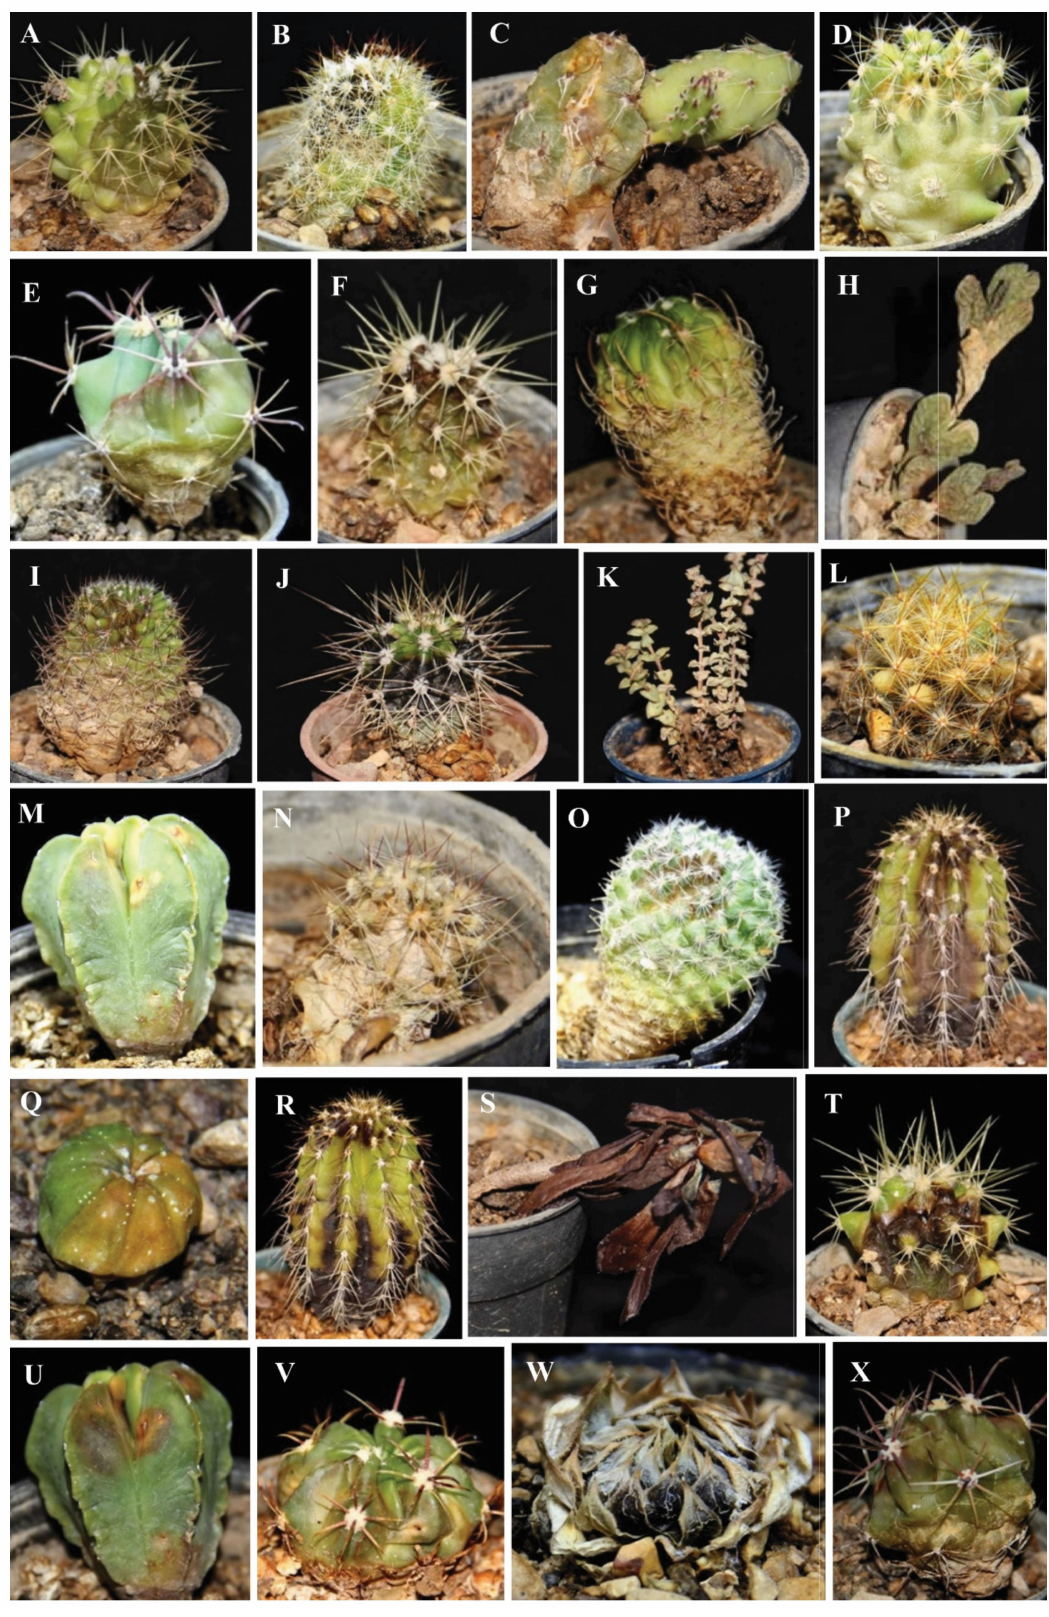
Figure 5. Symptoms induced by artificial inoculation of Fusarium oxysporum f. sp. opuntiarum on differ- ent succulent plants. ( A – C ) necrosis and yellowing on Echinocactus grusonii , Mammillaria spinosissima